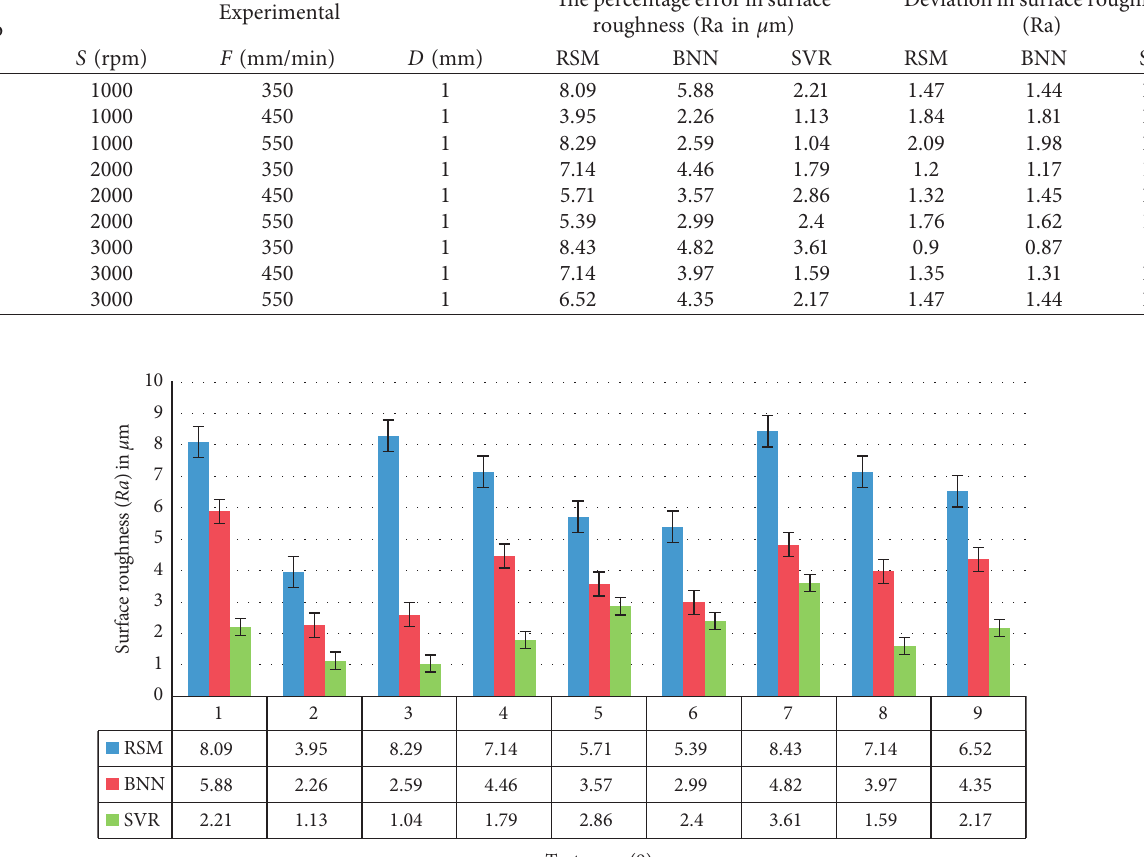
Table 4: Percentage error in Ra and deviation in Ra among prediction models RSM, BNN, and SVR compared to experimental results. SL. no